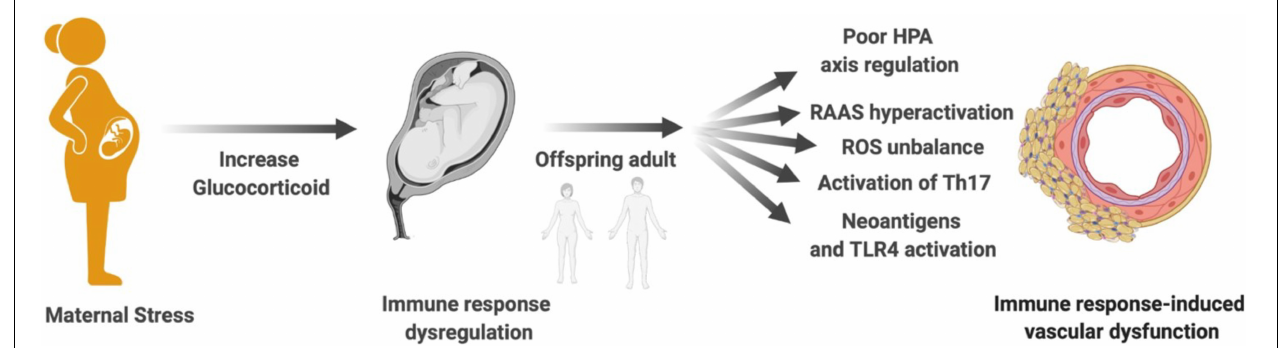
FIGURE 2 | Maternal stress, immune response, and vascular dysfunction. Mechanisms proposed to explain how maternal stress programming-induced immune response dysregulation in the offspring contributes to vascular dysfunction in adult life: poor HPA axis regulation, RAAS hyperactivation, ROS imbalance, activation of Th17, generation of neoantigens, and TLR4 activation. HPA, hypothalamic–pituitary–adrenal; RAAS, renin–angiotensin–aldosterone system; ROS, reactive oxygen species; Th17, T helper lymphocyte 17; TLR4, toll-like receptor